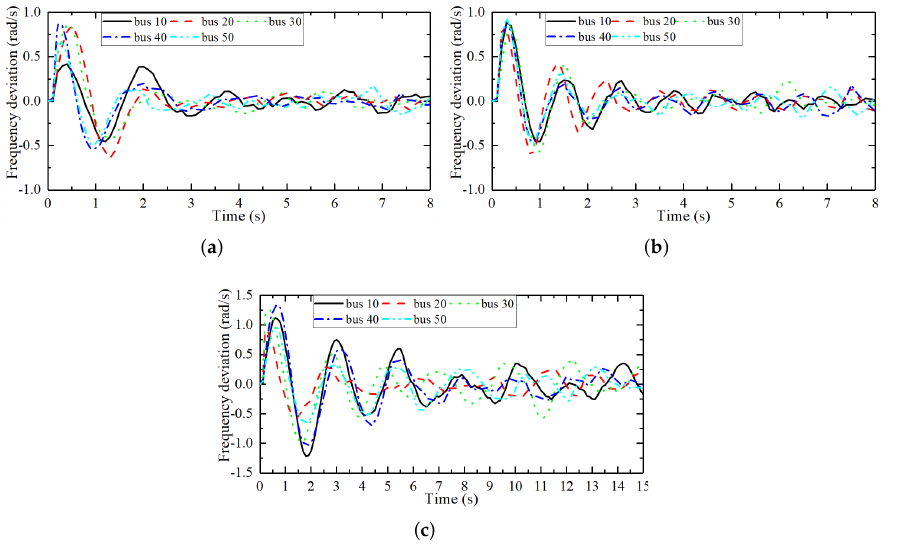
Figure 15. Frequency deviation curve of the IEEE 57 bus testing system under three different methods, η ji = 0.2. ( a ) Based on convex neural networks. ( b ) Based on RBF neural networks. ( c ) Based on RNN neural